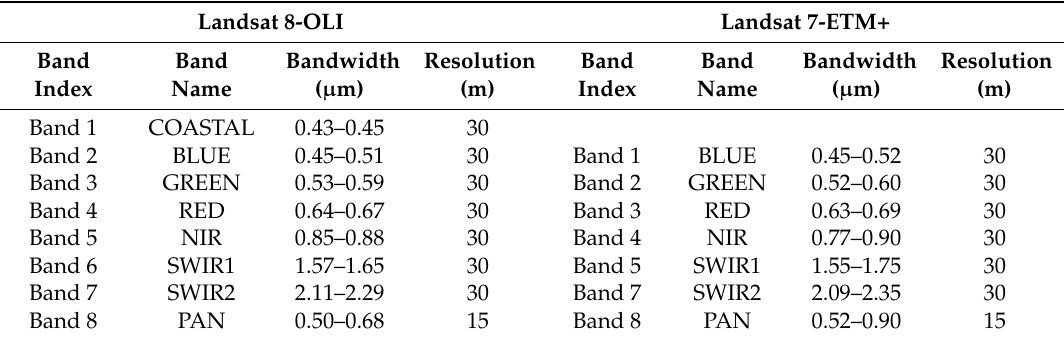
Table 1. Comparison of Landsat 7 and Landsat 8 satellite